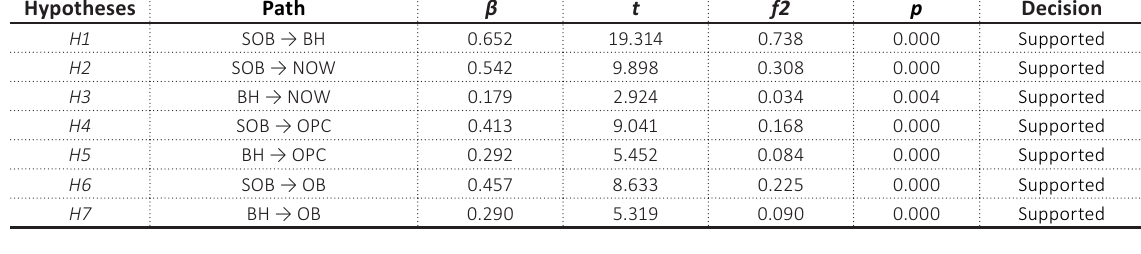
Table 4. Hypotheses testing